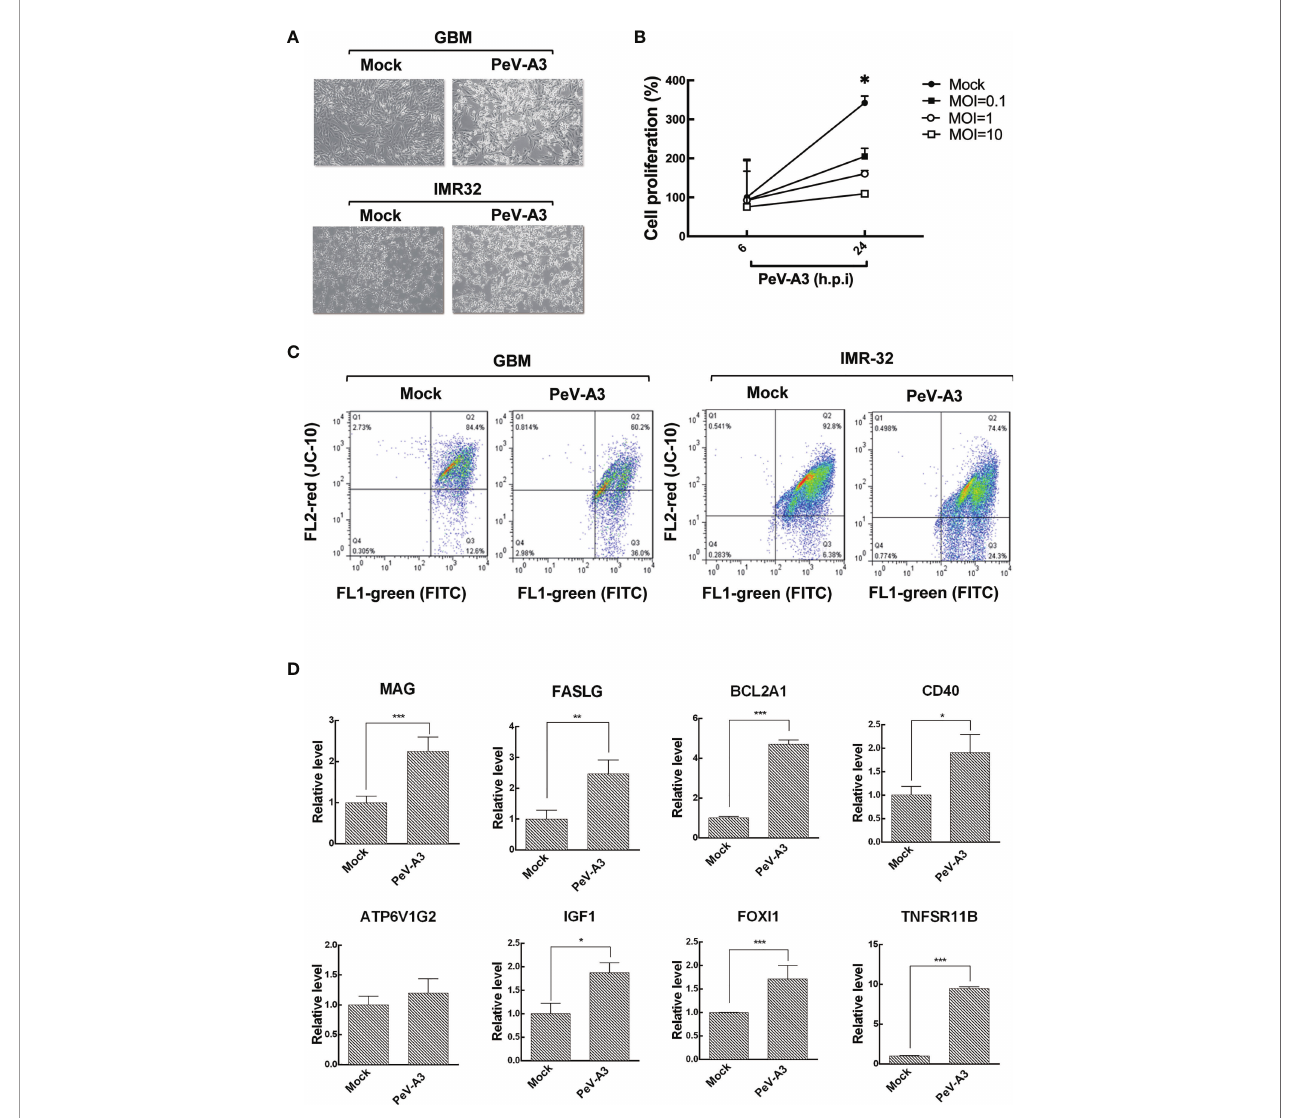
FIGURE 3 | PeV-A3 induced cell death. (A) CPE observation of GBM and IMR-32 cells infected with PeV-A3 at MOI = 1 for 24 h. (B) WST-1 assay was conducted in GBM cells infected with PeV-A3 at MOI = 0.1, 1, and 10 for 6 and 24 h. Cell viability was detected in a microplate ELISA reader at absorbance OD 450 nm and reference wavelength OD 620 nm. (C) Flow cytometry analysis of JC-10 mitochondrial membrane potential detection in PeV-A3-infected GBM and IMR-32 cells. Cells located in Q2 area are healthy. Cells located in Q3 are damaged, showing loss of mitochondrial inner membrane potential. (D) RT-qPCR analysis of genes identi fi ed using RT 2 array. RT-qPCR was conducted in PeV-A3-infected GBM cells and mock controls. Data are mean ± SD of three independent experiments. Student ’ s t-test, * p < 0.05; ** p < 0.01; *** p < 0.005 compared with mock controls. PeV-A3, parechovirus type 3; CPE, cytopathic effect; GBM, glioblastoma; MOI, multiplicity of infection; OD, optical